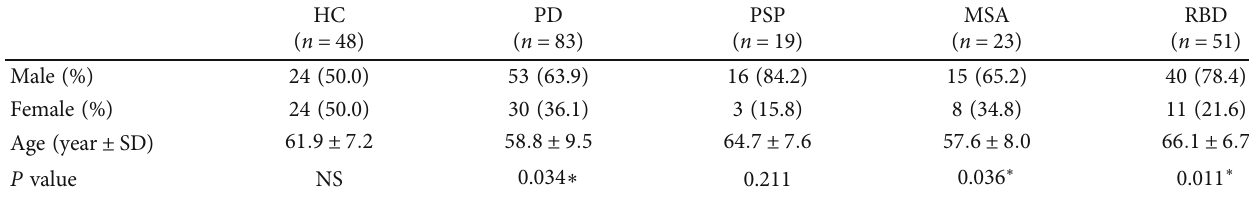
Table 5: Characteristics of